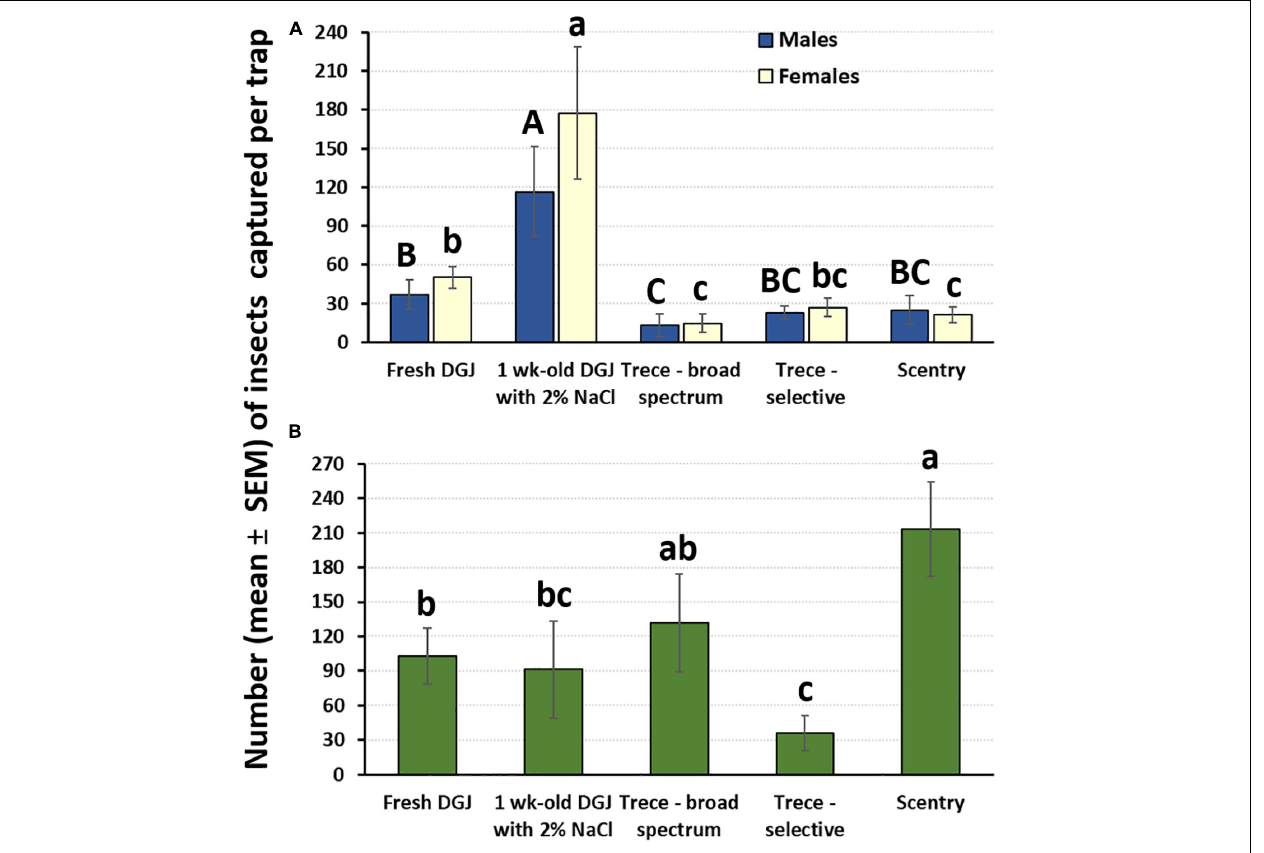
FIGURE 8 | Captures (means ± SEM) of (A) male and female D. suzukii and (B) other drosophilids in traps baited with diluted Concord grape juice (DGJ) either, fresh or aged for 7 days with 2% of NaCl added prior to fermentation vs. three commercial lures. Study conducted in a commercial raspberry orchard in Hatfield, MA, from 26 July to 12 August 2021. For each sex of D. suzukii , different letters indicate significant differences according to ANOVA and Tukey HSD tests at P =